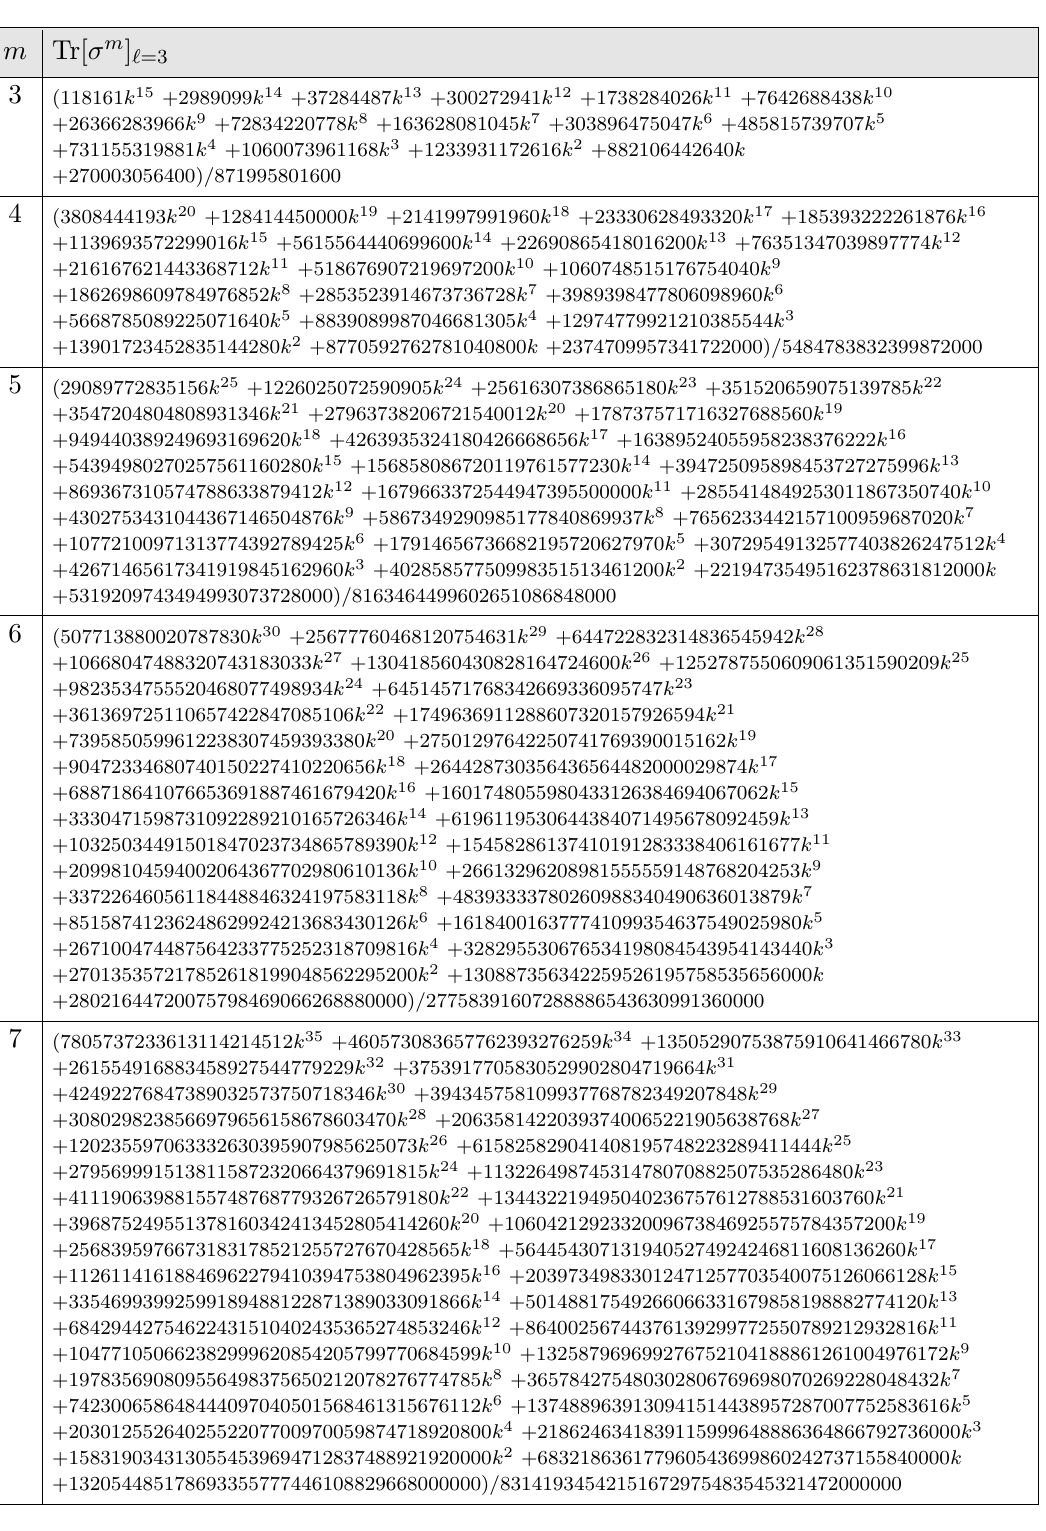
Table 10. The values of Tr [ σ m ] as a function of k for T 3 , 12 torus link. The subscript ‘ indicates that the polynomial is valid for k ≡ ‘ ( mod 4)